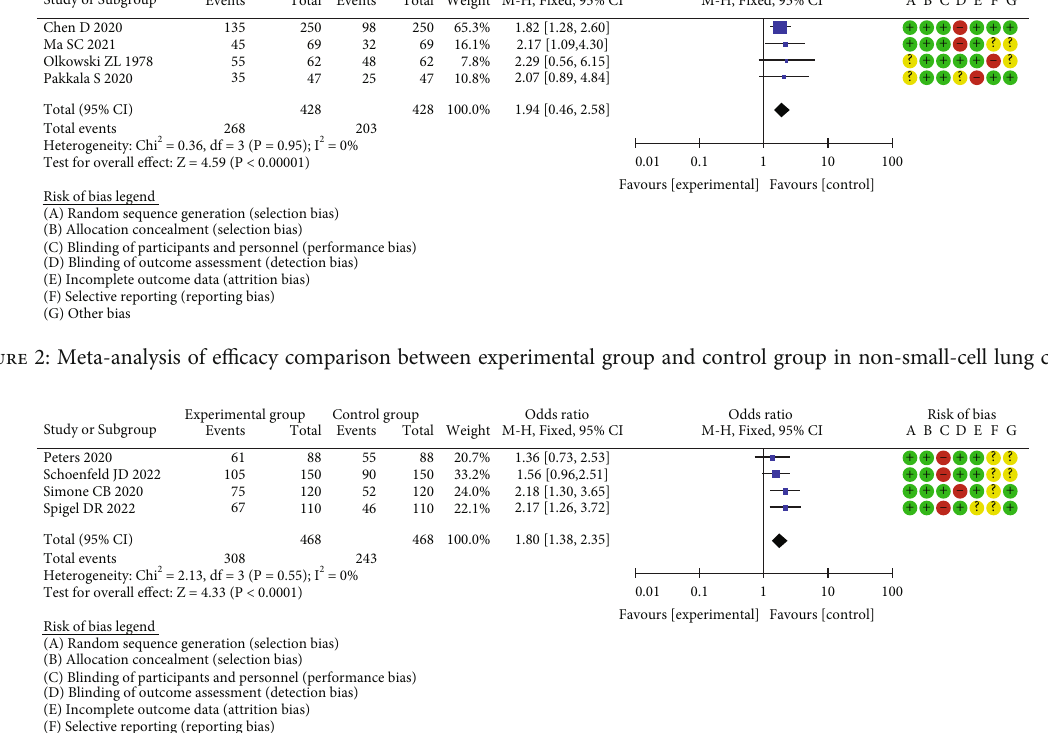
Risk of bias legend (A) Random sequence generation (selection bias) (B) Allocation concealment (selection bias) (C) Blinding of participants and personnel (performance (D) Blinding of outcome assessment (detection bias) (E) Incomplete outcome data (attrition bias) (F) Selective reporting (reporting bias) (G) Other bias Figure 3: Meta-analysis of the e ff ect of adoptive immunotherapy on disease progression in experimental group and control group in non- small-cell lung cancer.